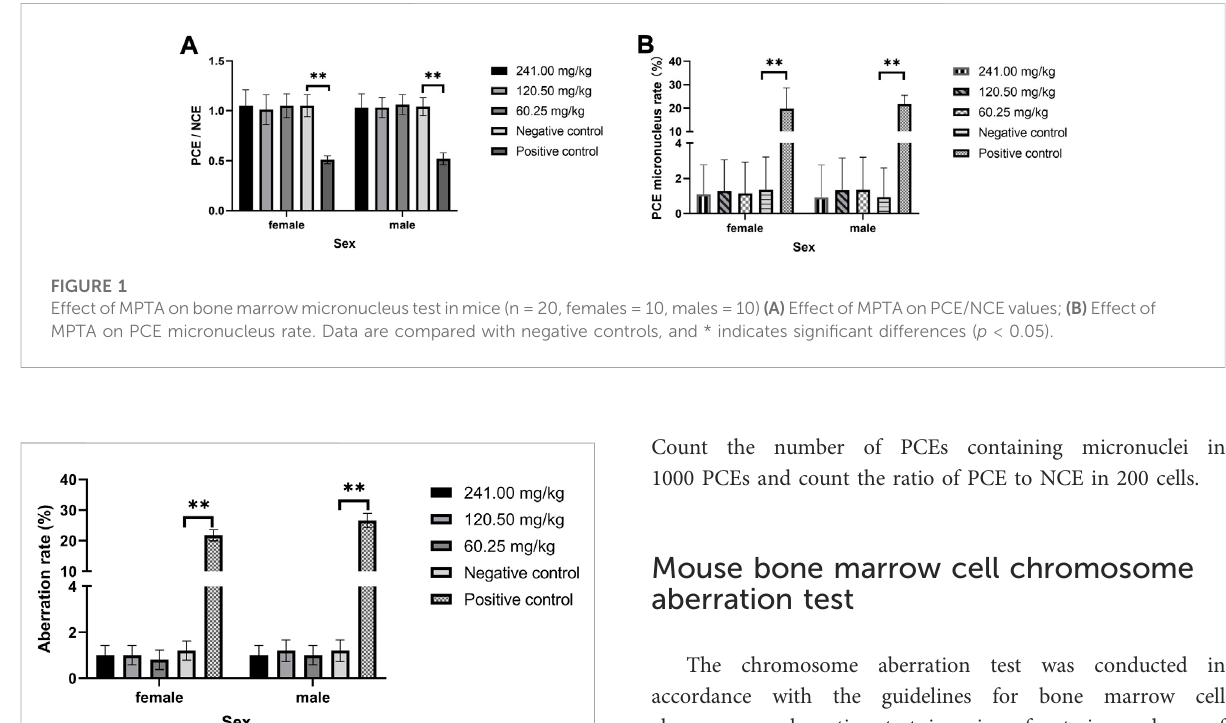
FIGURE 2 Effect of MPTA on the rate of chromosomal aberrations in mousebonemarrowcells(n=16,females=8,males=8).Dataare compared with negative controls, and * indicates signi fi cant differences ( p < 0.05).